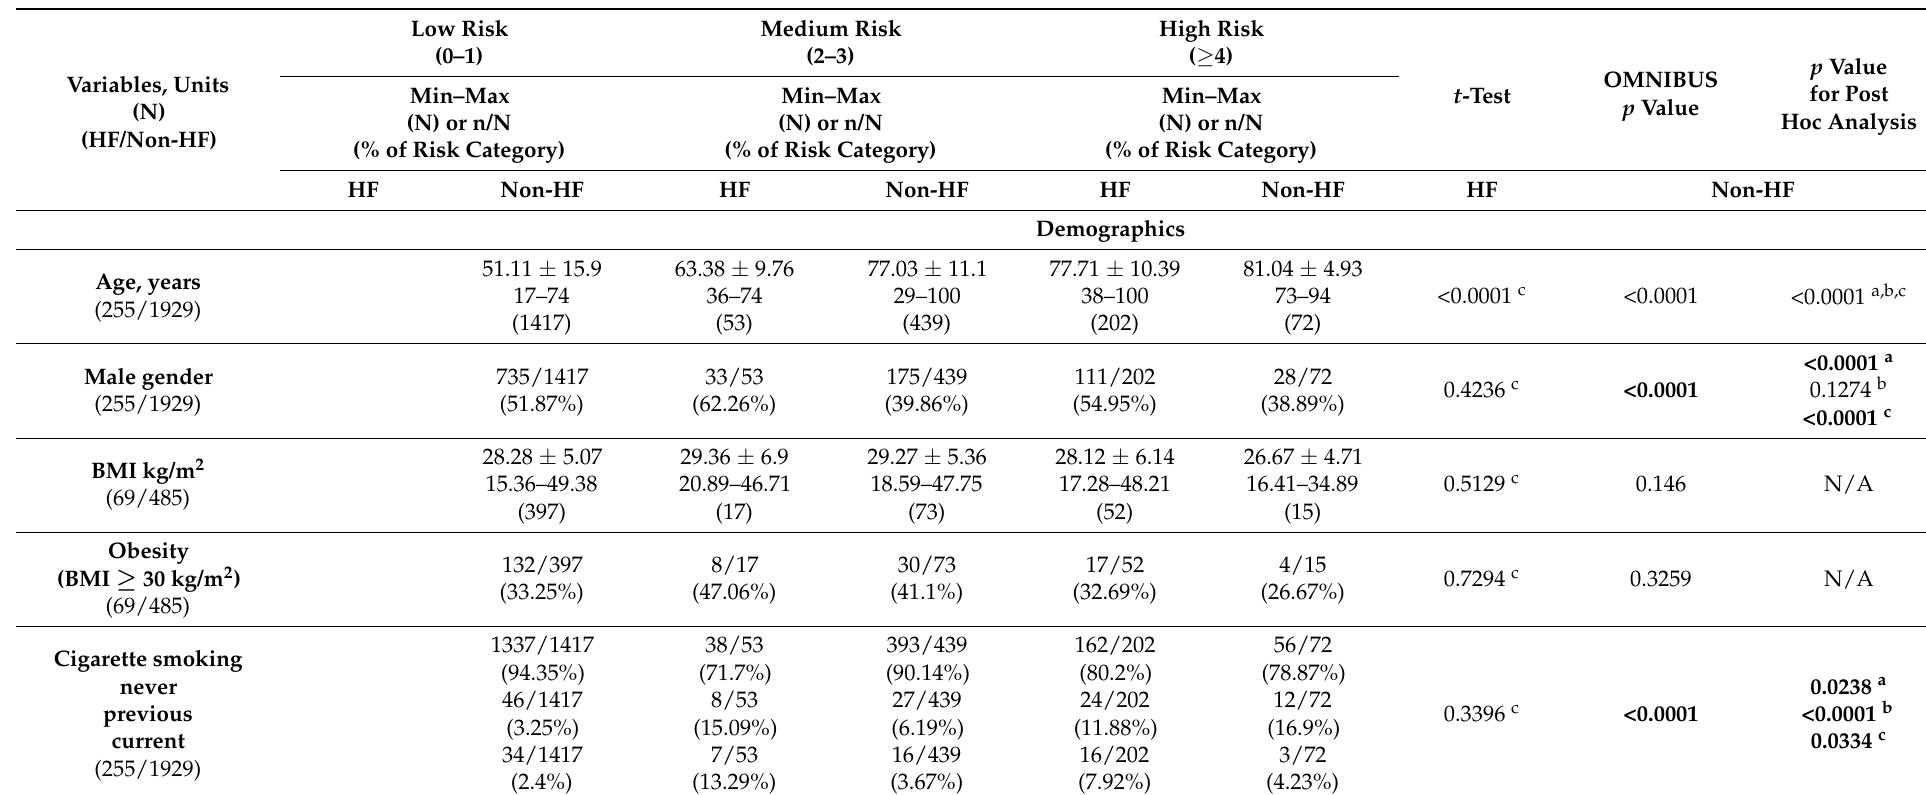
Table 1. Baseline characteristics after C 2 HEST risk stratification in the HF and non-HF study